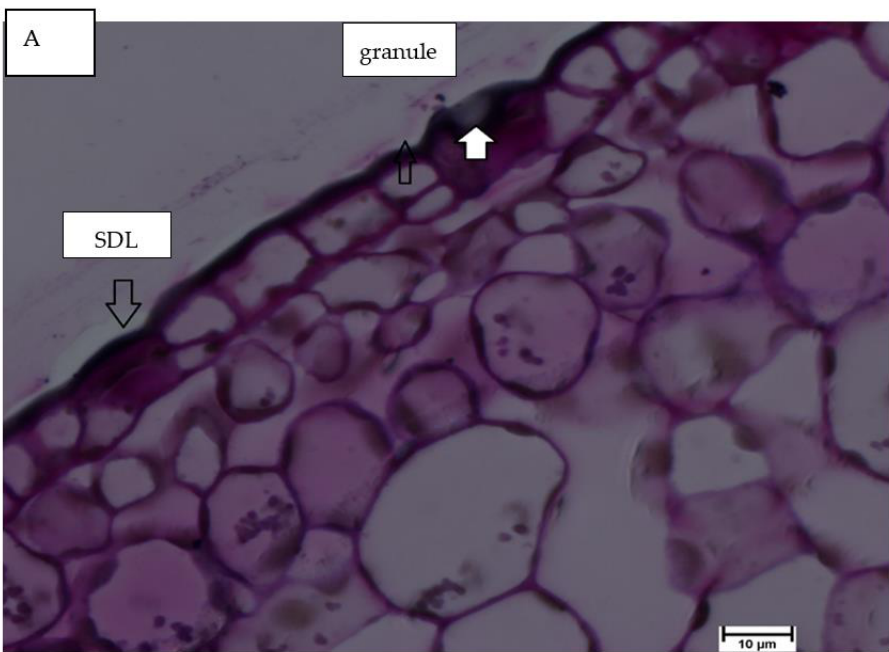
Figure 1. Upper epidermal surface of Si treated citrus leaves examined under light microscopy, 100 × magnification: arrows in diagram mark silica granules in the epidermal surface; Si deposits in the outer cell regions constitute the cuticle- silica double layer (SDL) (Mvondo-She and Marais [93]). 4. Green and Blue Mold